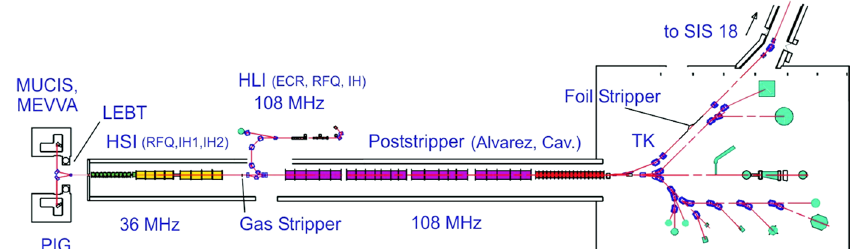
FIG. 1. (Color) The UNIversal Linear ACcelerator UNILAC at